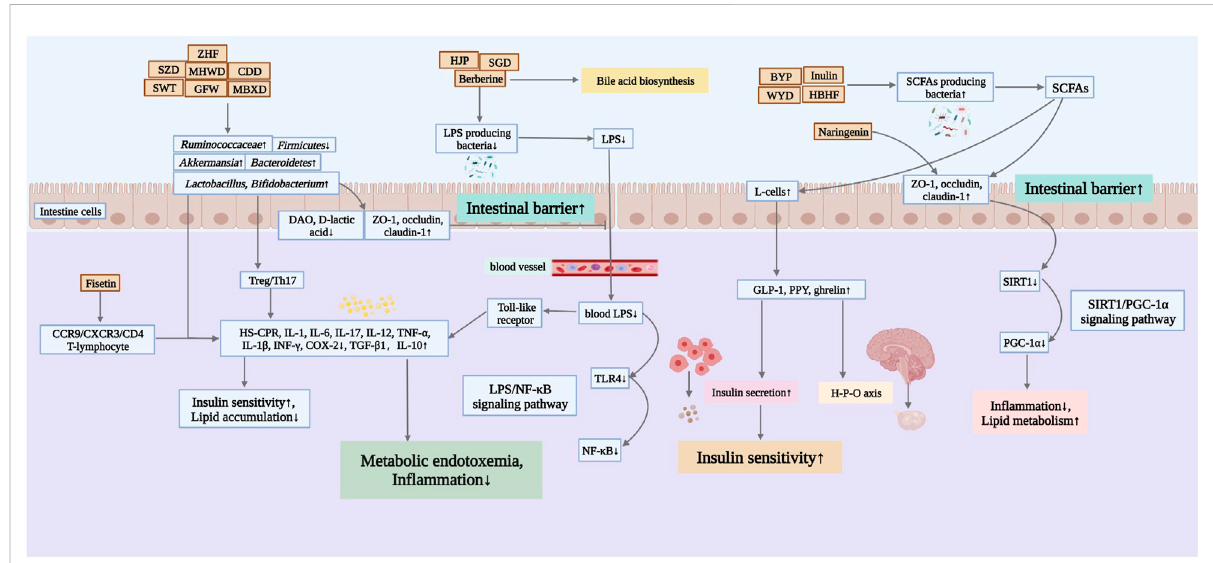
FIGURE 2 Mechanisms of Chinese herbal medicines in improving female reproductive disorders by regulating the intestinal fl ora. ZHF, Zhishen Huatan Formula; SZD, Shaofu Zhuyu Decoction; MHWD, Modi fi ed Huanglian Wendan Decoction; CDD, Cangfu Daotan Decoction; SWT, Siwu Tang; GFW, Guizhi Fuling Wan; MBXD, Modi fi ed Banxia Xiexin Decoction; HJP, Huayu Jiedu Prescription; SGD, Shaoyao-Gancao Decoction; BYP, Buzhong Yiqi Prescription; WYD, Wang ’ s YiJing Decoction; HBHF, Hashi Bushen Huatan